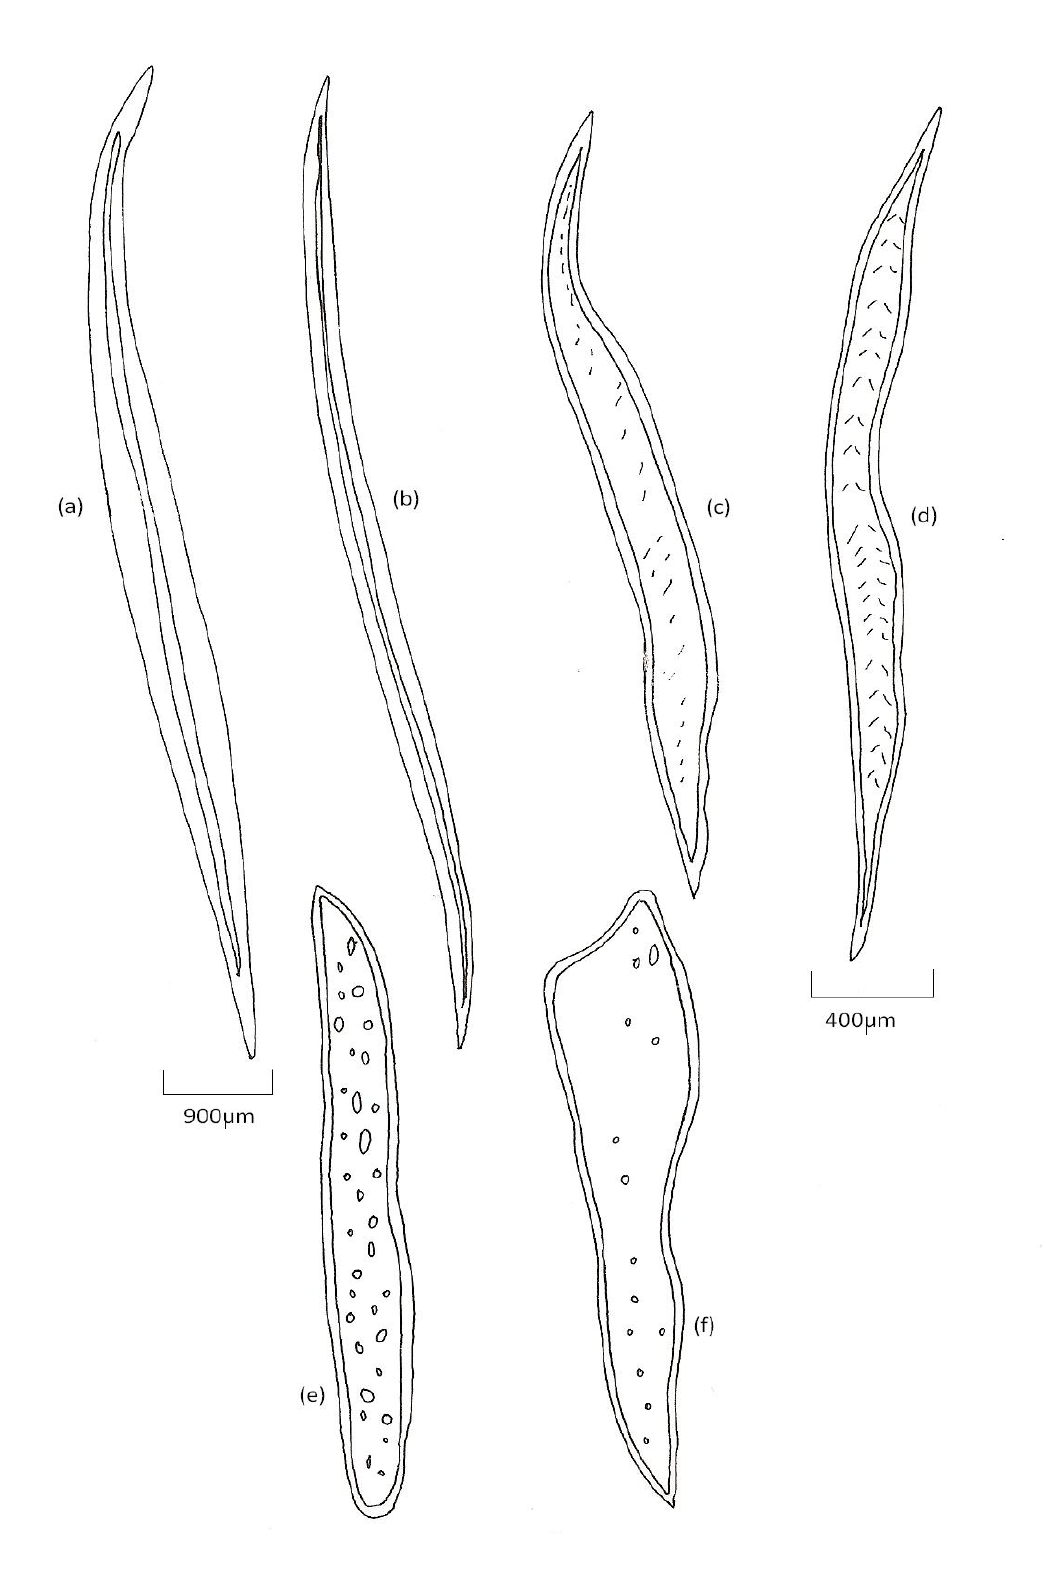
Fig. 5. Diagrammatic illustration of fibre types in Annona muricata ; Diagram a-b: Libriform Fibres in Annona muricata ; Diagram c-d: Simple slit-like pitted fibre-tracheids in Annona muricata ; Diagram e-f: Simple circular-like pitted fibre-tracheids in Annona